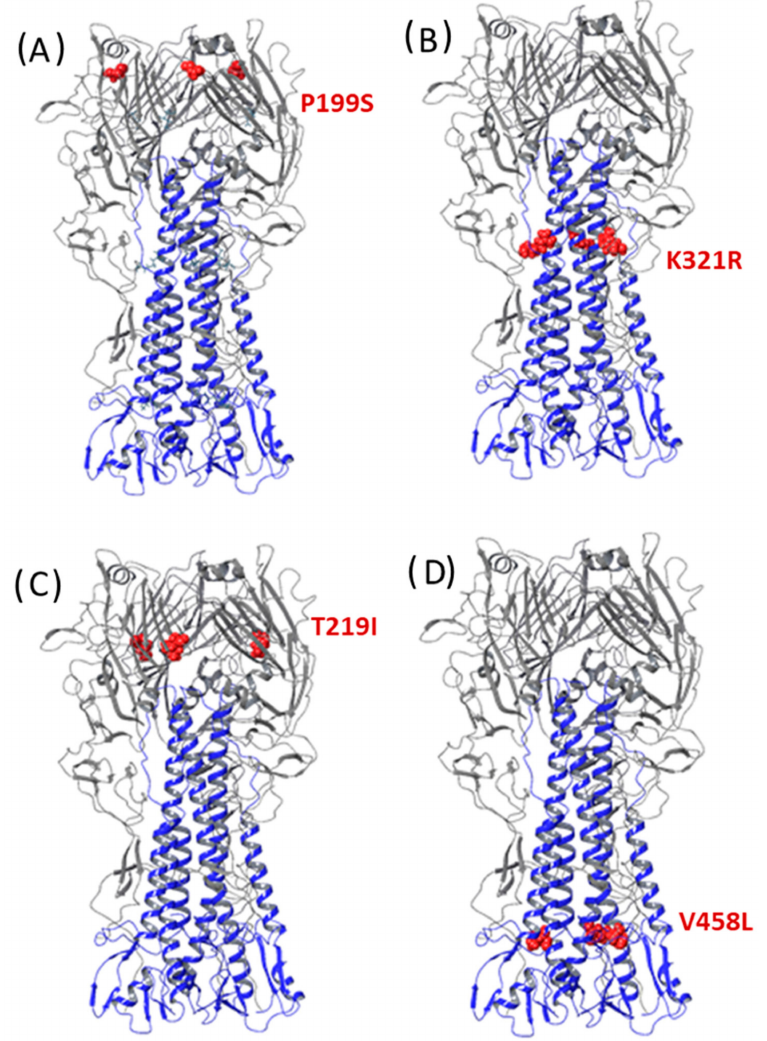
Figure 8. Localization of amino acid substitutions in GS-R virus compared to PR8 (GenBank: CY121109.1). ( A) P199S; ( B ) K321R; ( C ) T219I; ( D )